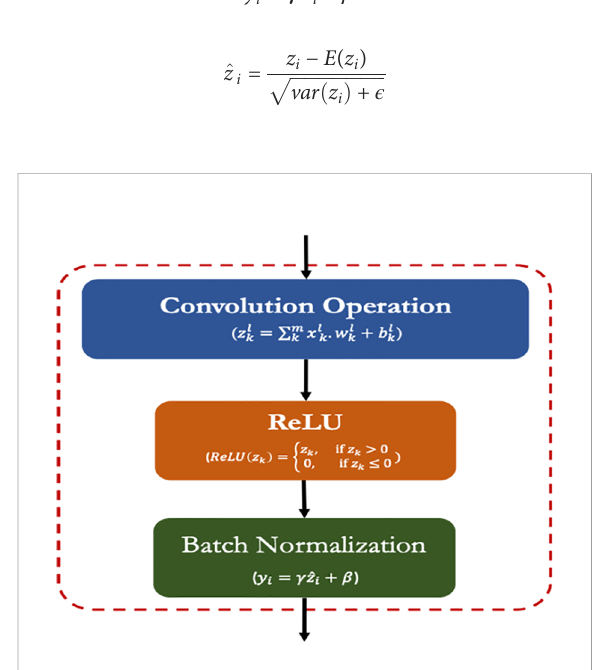
FIGURE 3 Framework of the CRB module of the proposed